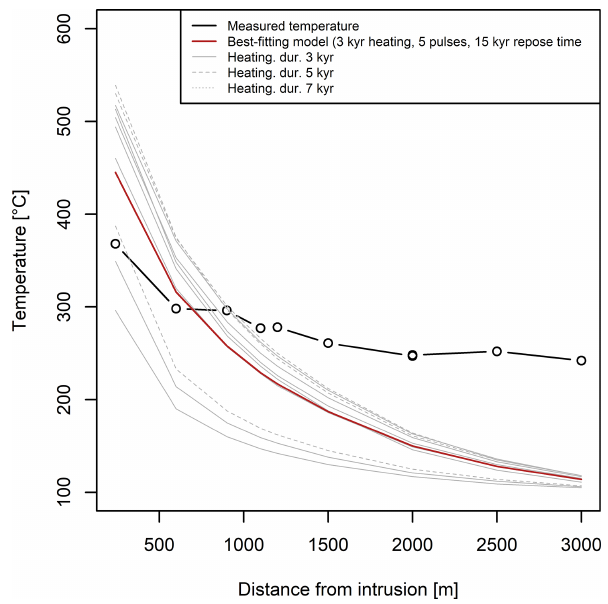
Figure 10. Comparison between measured Raman temperatures and modeled temperatures in the contact aureole of the Torres del Paine intrusion, using the best framework parameters (Fig. 9c). We are using the two-batch model at 800 ◦ C intrusion temperature. The best-fitting model is marked in red and represents a model with short heating duration, five pulses, and long repose times (i.e.,